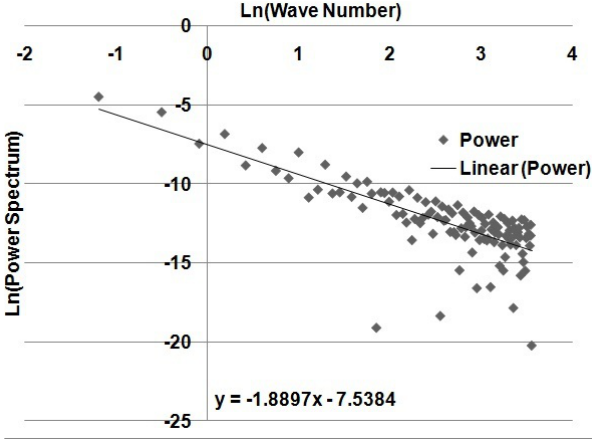
Fig. 4. Log-log plot of power spectrum of heat production data vs. wave number for the Hidaka metamorphic belt (Hokkaido, Japan). Best linear fit gives scaling exponent of 1.9 indicating presence of fractal behavior in the data set. Nature of linear fit indicates strong correlation between the adjacent points and substantiate power law regime in the data.